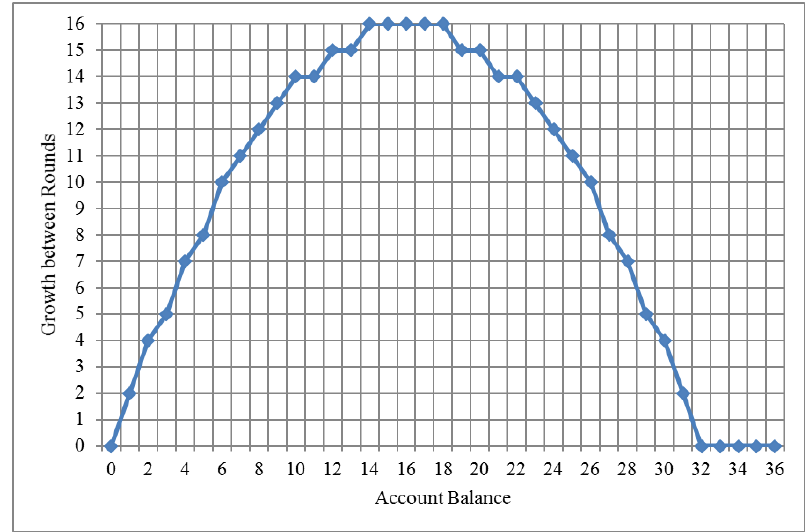
Figure 1. Growth function.